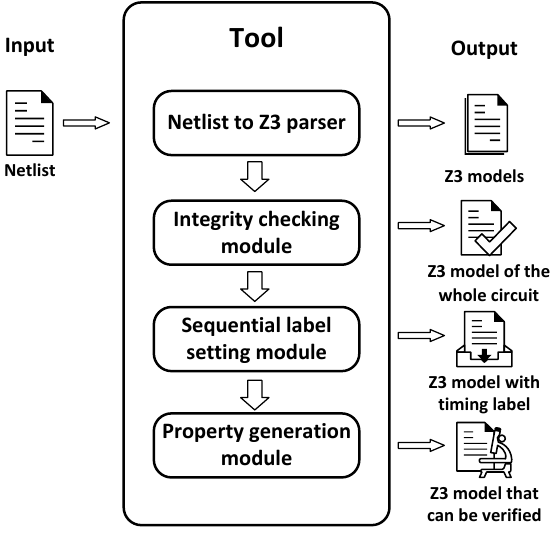
Figure 5. Structure of the designed tool.